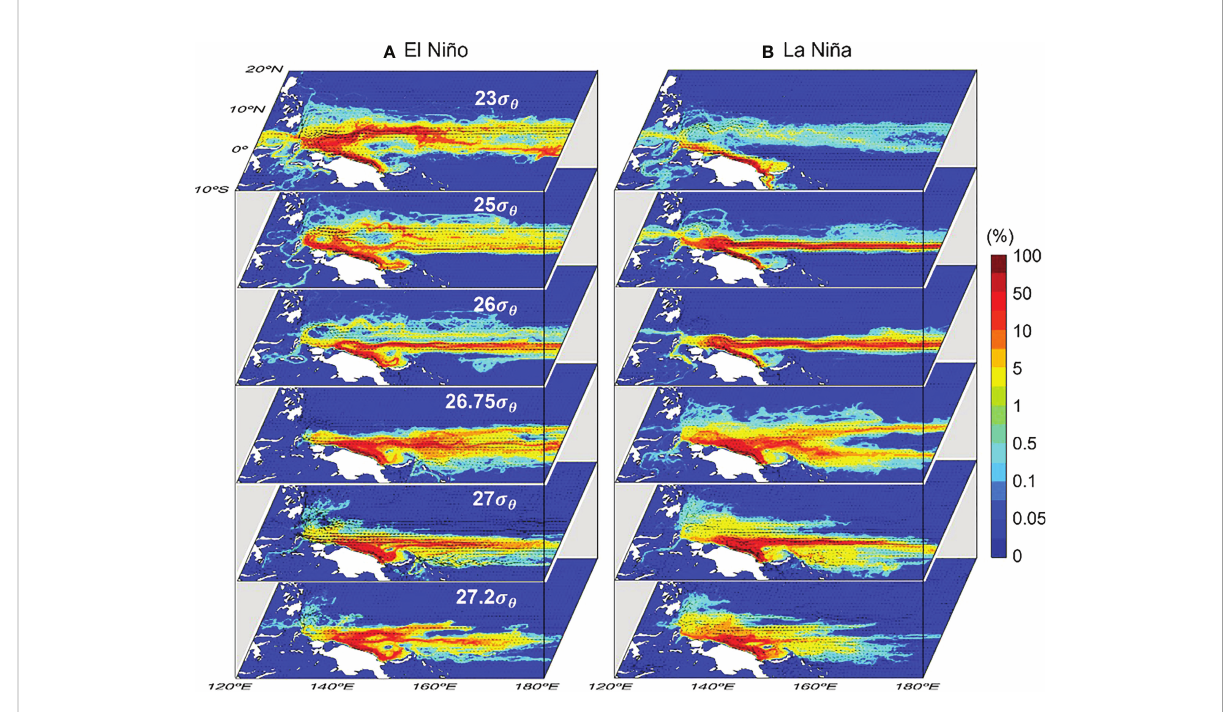
FIGURE 10 Same as Figure 8 except the tracers were released during (A) El Niño and (B) La